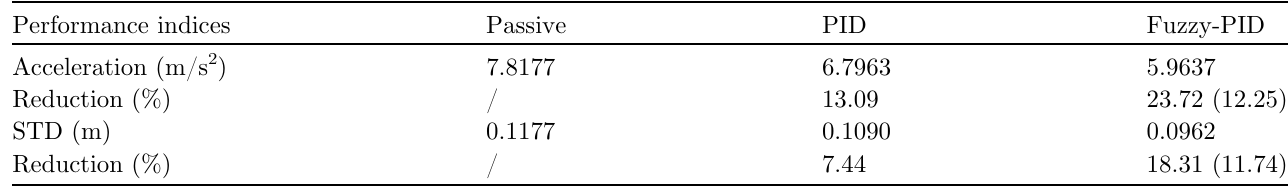
Table 9. Peak-to-peak values under bump road pro fi